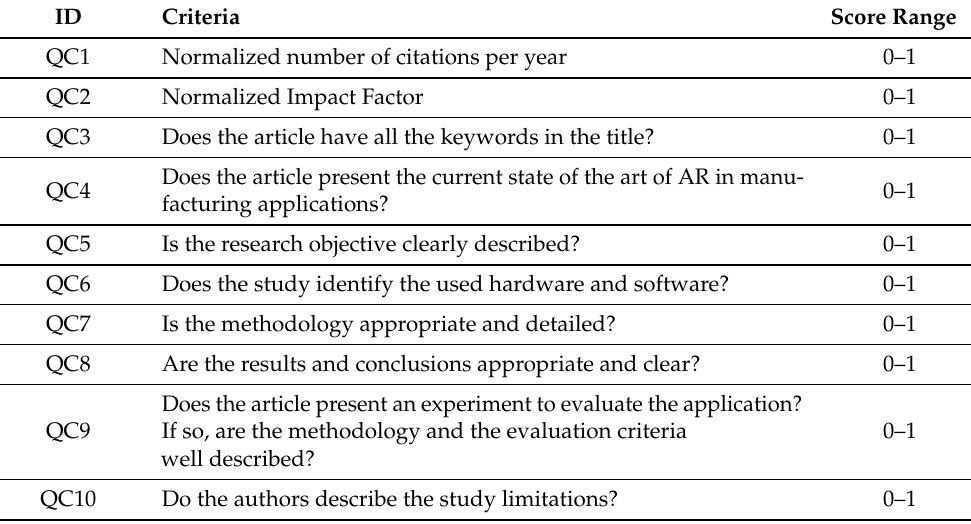
Table 6. Quality assessment criteria and statistical